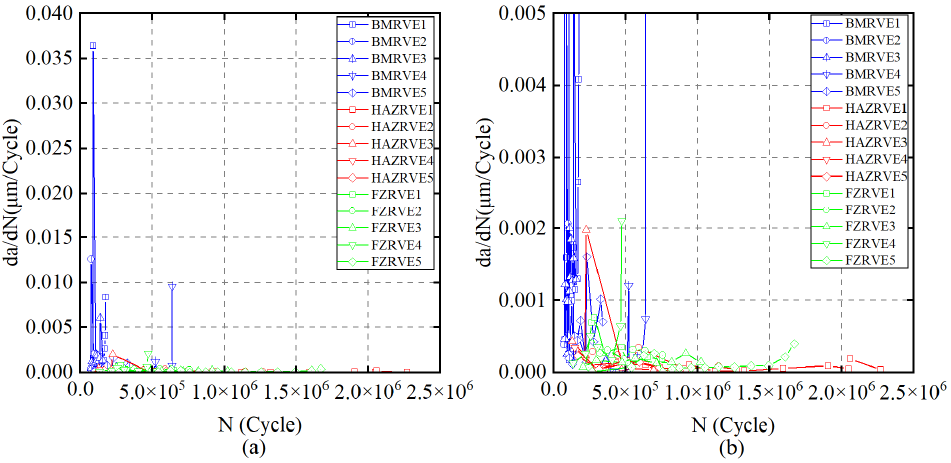
Figure 16. ( a ) MSC expansion rate and life in different areas of the weld toe. ( b ) Partial enlarged view.